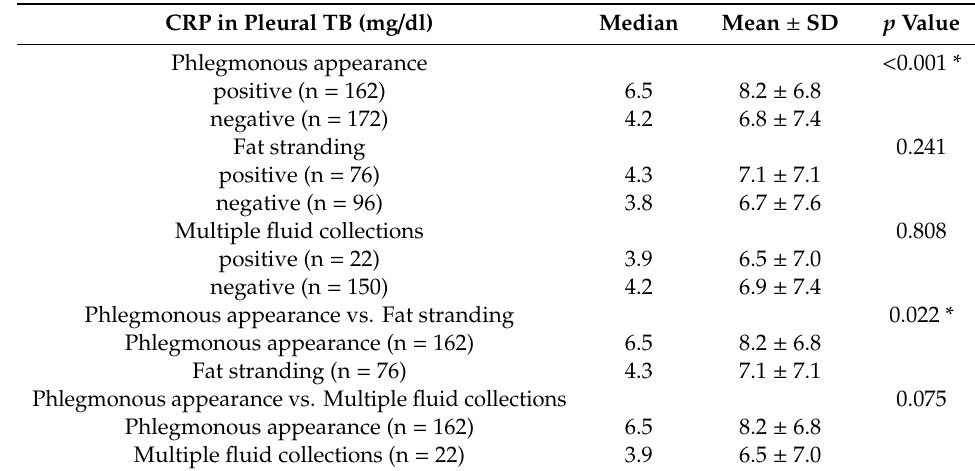
Table 5. Association between serum C-reactive protein and paracardiac CT findings in patients with pleural